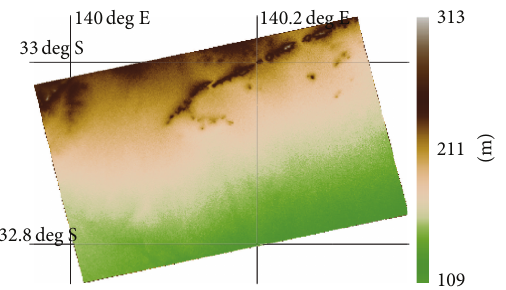
Figure 5: DEM of the Quandong test site.